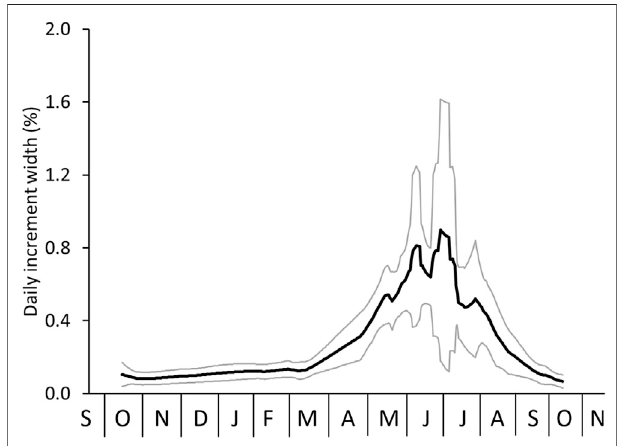
FIGURE 3| Seasonal growth model (daily resolution) of Arctica islandica from NE Iceland (average = black line; 1 σ error = grey) based on 11 specimens. Data taken from Höche et al.